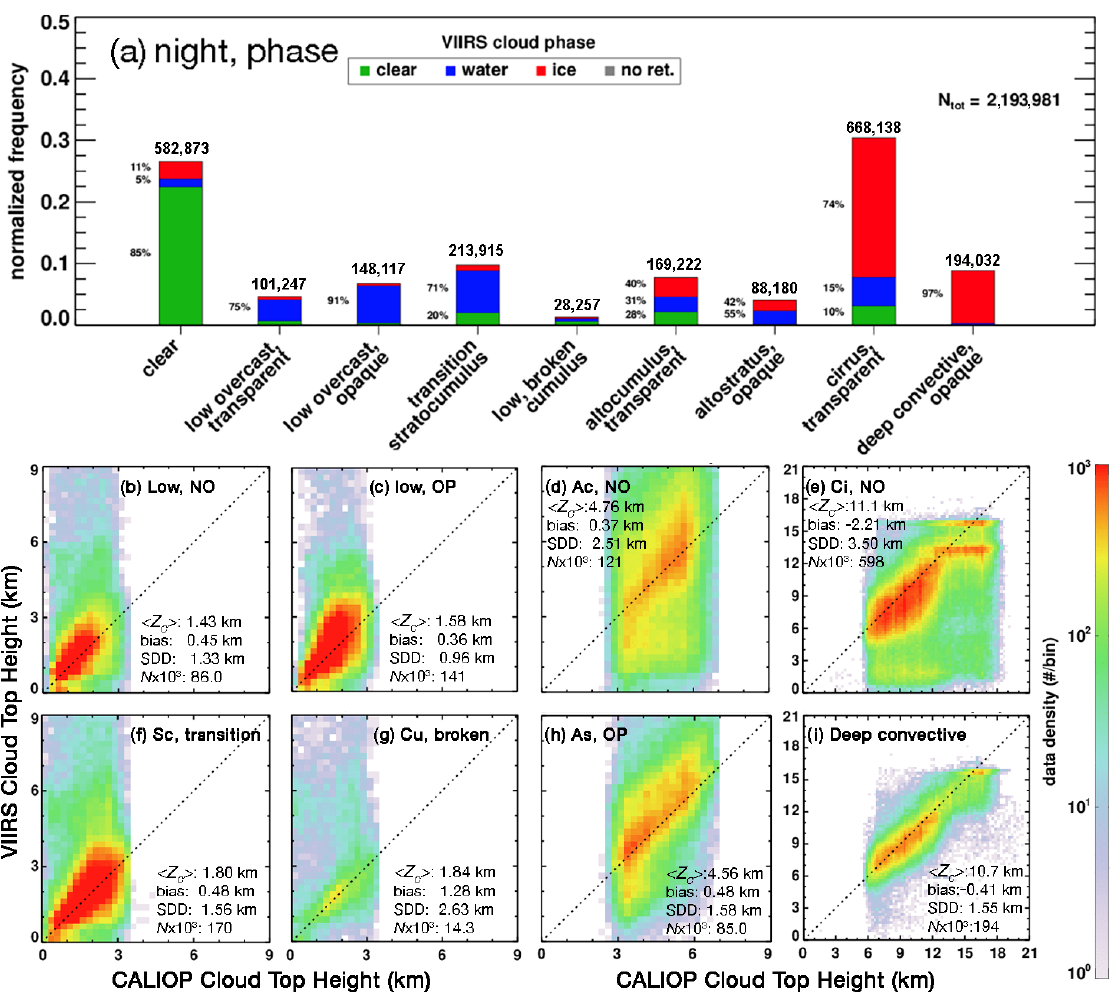
Figure 19. Same as Figure 18, except for nighttime data.